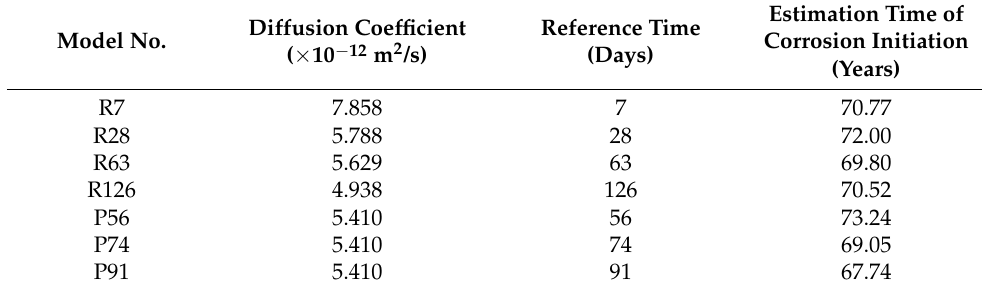
Table 3. Results of the